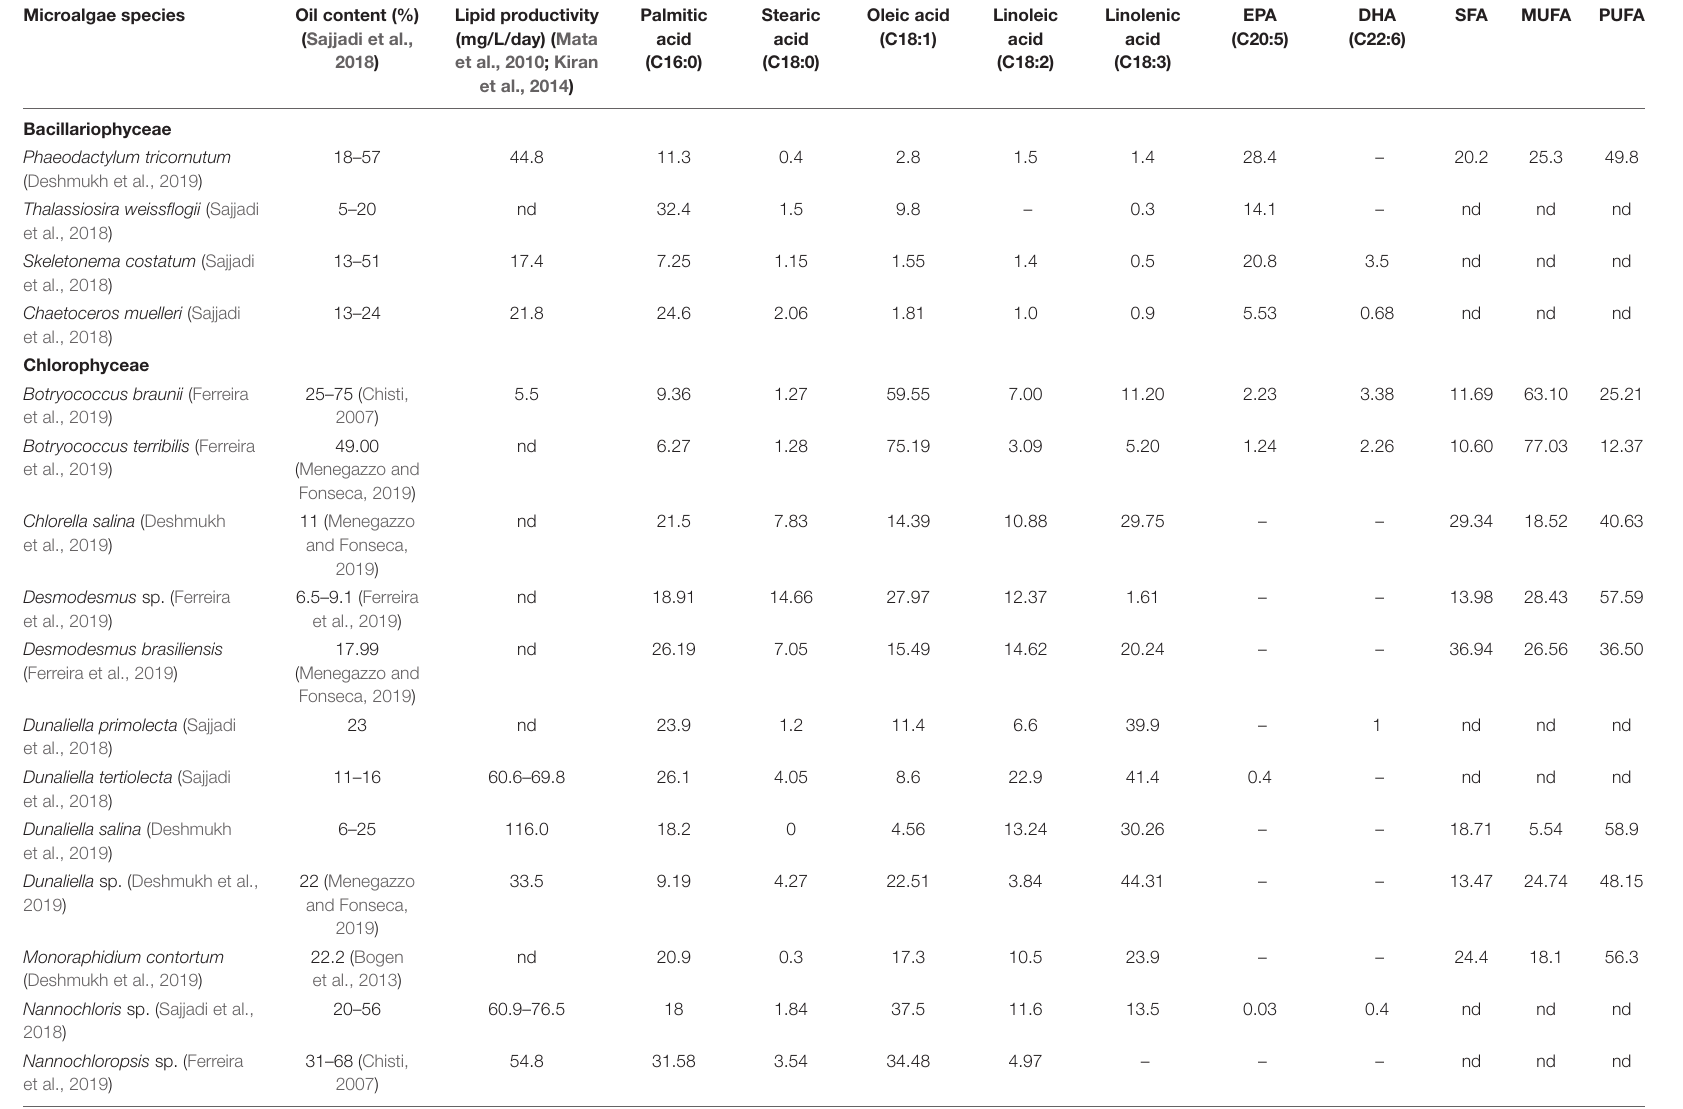
TABLE 2 | Lipid content and fatty acids composition of different microalgae species. Microalgae